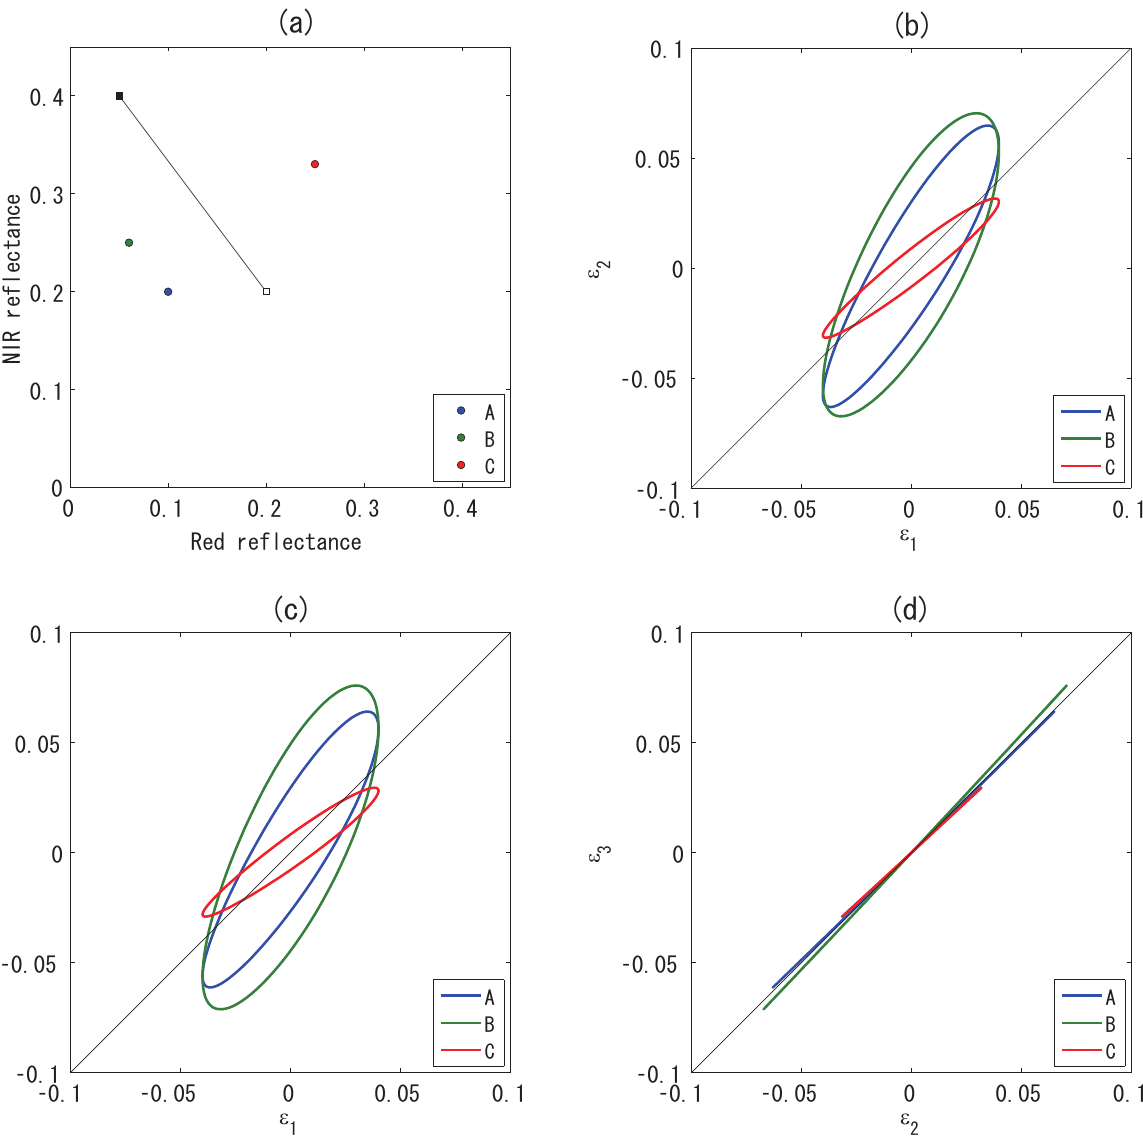
Figure 3 . Relationships among the errors propagated in each of the three algorithms, obtained by numerical simulation. (a) Plots of the endmember spectra and the three target spectra used in the simulation. The target spectra A, B, and C are indicated by blue, green, and red circles, respectively, in (a). Vegetation and non-vegetation endmember spectra are denoted by the filled and empty squares, respectively. The solid line indicates the subspace modeled by the reflectance-based LMM. (b) Cross plot of the propagated error using algorithms-1 ( ϵ ) and -2 ( ϵ ). The relationships among errors propagated in the three 1 2 target spectra, obtained by simulation, are represented by the lines of the corresponding color, blue, green, and red, for A, B, and C, respectively. Similarly, (c) and (d) are the relationships between algorithms-1 ( ϵ ) and -3 ( ϵ ), and between algorithms-2 ( ϵ ) and -3 ( ϵ ), respectively. 1 3 2 3 Note that NDVI was chosen as the conditions or constraints used in algorithms-2 and -3 for those